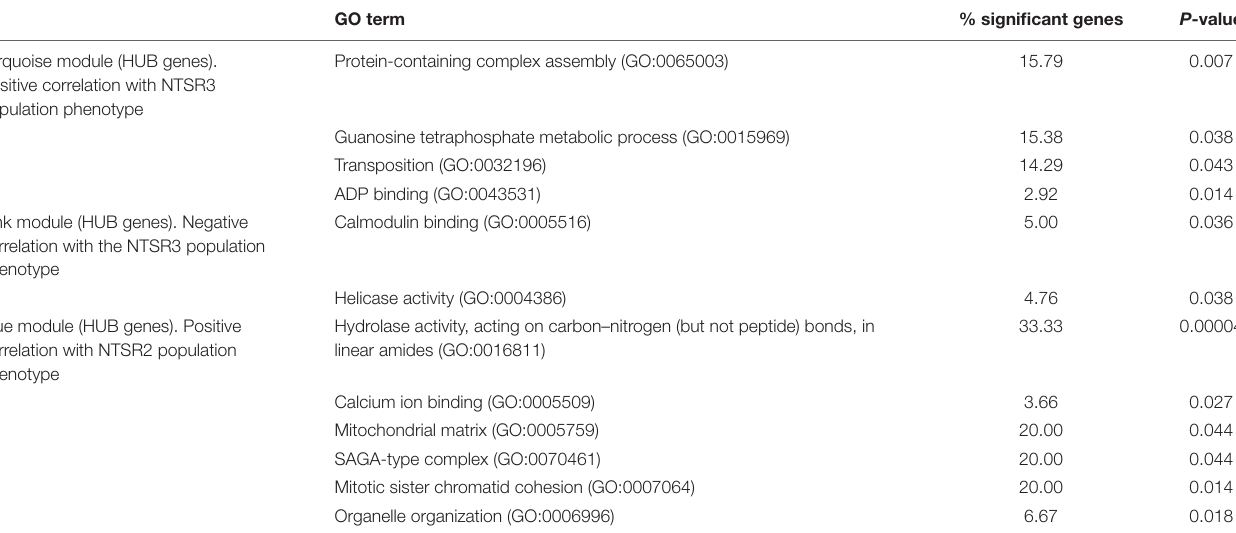
TABLE 2 | Gene Ontology (GO) enrichment (biological process, molecular function, and cellular component) of the HUB gene list of the turquoise, pink, and blue WGCNA modules highly correlated with the NTSR2 and NTSR3 phenotypes. GO term % significant genes P -value Turquoise module (HUB genes). Positive correlation with